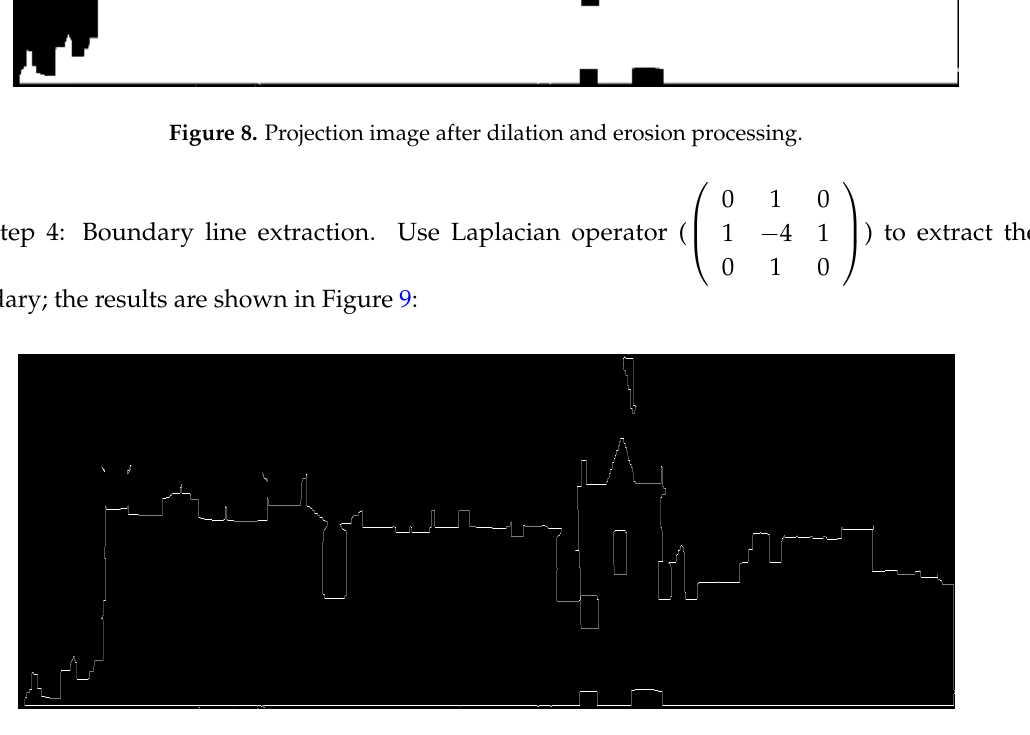
Figure 9. Boundary extraction result of the building.